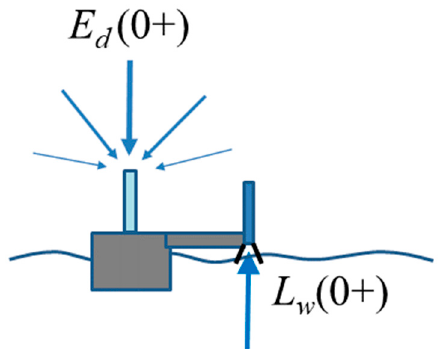
Figure 7. Schematic of above-water radiometry with skylight-blocked approach. Note that the radiometer fore-optics are in air, but the radiometer body is extended with a cone or shield (black lines) that extends below the water surface, ensuring blocking of skylight reflection.